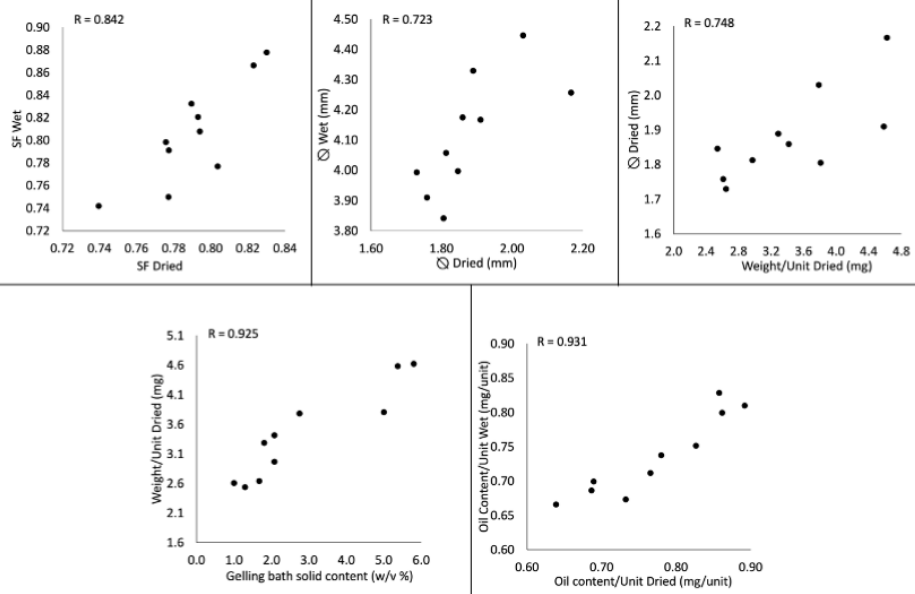
Figure 1. Correlation plots obtained by mixture design.